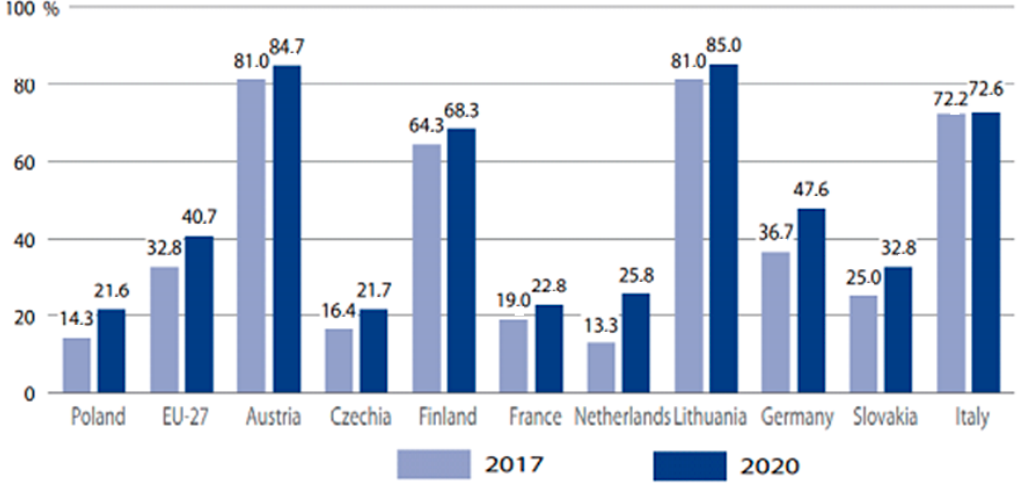
Figure 1. Share of energy from renewable sources in total primary energy in 2017 and 2020. Source: Renewable energy in 2021, CSO, Warsaw, 2022.